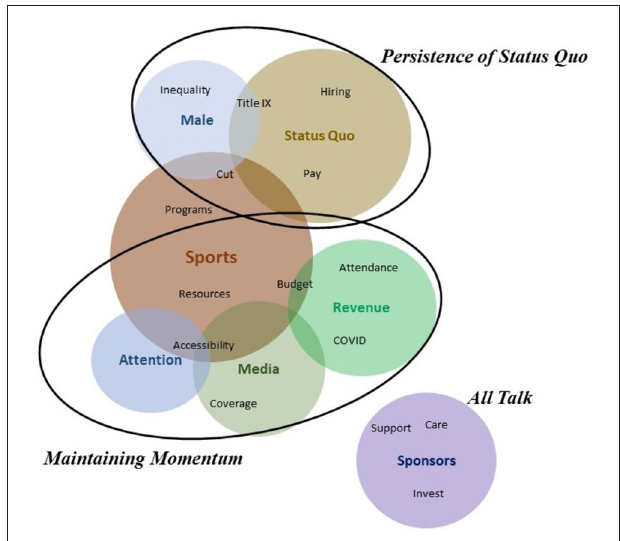
FIGURE 2 | Thematic representation of the frames for question